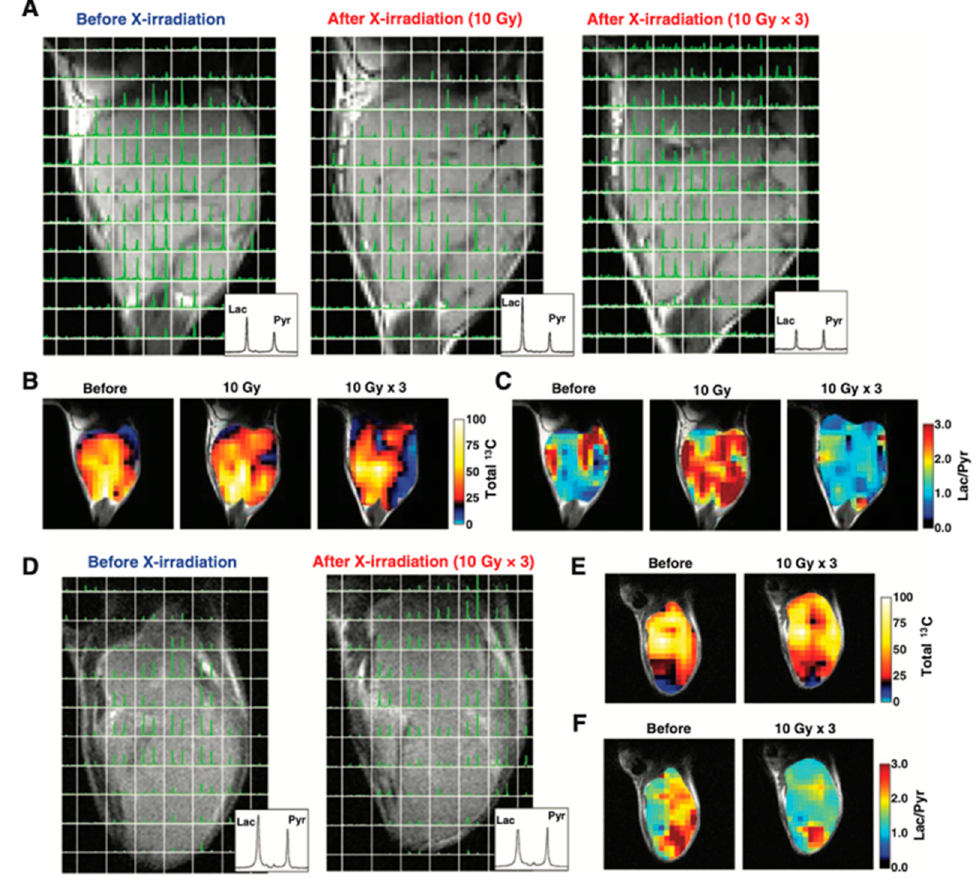
Figure 10. Therapeutic response of mice-bearing a SCC tumor ( A – C ) or a HT29 tumor ( D – F ) upon the X-ray irradiation. Chemical shift images of the SCC tumor ( A ) and HT29 tumor ( D ) obtained before irradiation, at 1 day after 10 Gy of irradiation, and at 1 day after fractionated 30 Gy irradiation. Total 13 C maps ( B , E ) and images of the [1- 13 C]lactate to [1- 13 C]pyruvate ratio ( C , F ) in the SCC tumor and the HT-29 tumor calculated from the chemical shift